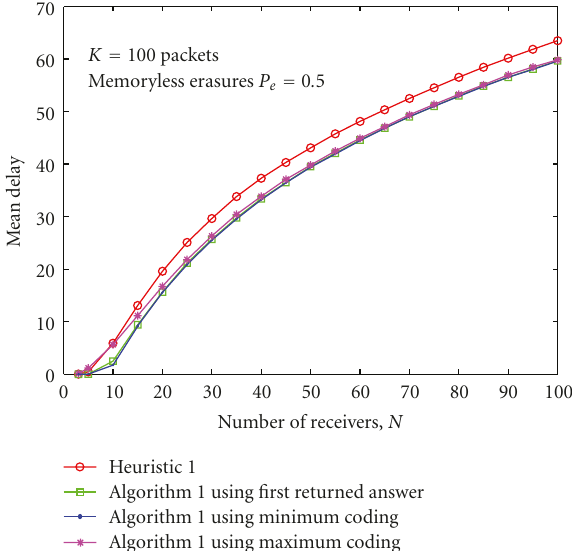
Figure 3: Mean decoding delay for the transmission of K = 100 packets to N = 3 to N = 100 receivers. Algorithm 1 is compared with Heuristics 1–3. Both Heuristics 2 and 3 perform very closely to Algorithm 1. The maximum number of recursions for both Heuristic 2 and 3 is set to 100.